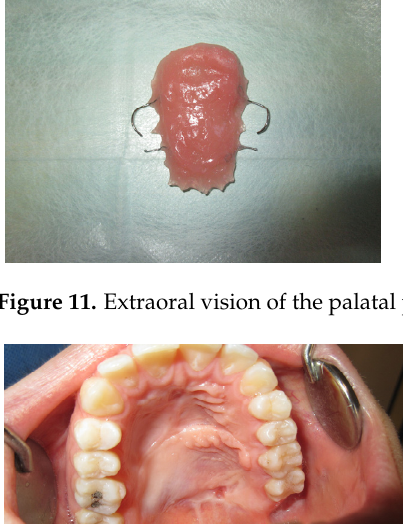
Figure 10. Palatal plate in position.